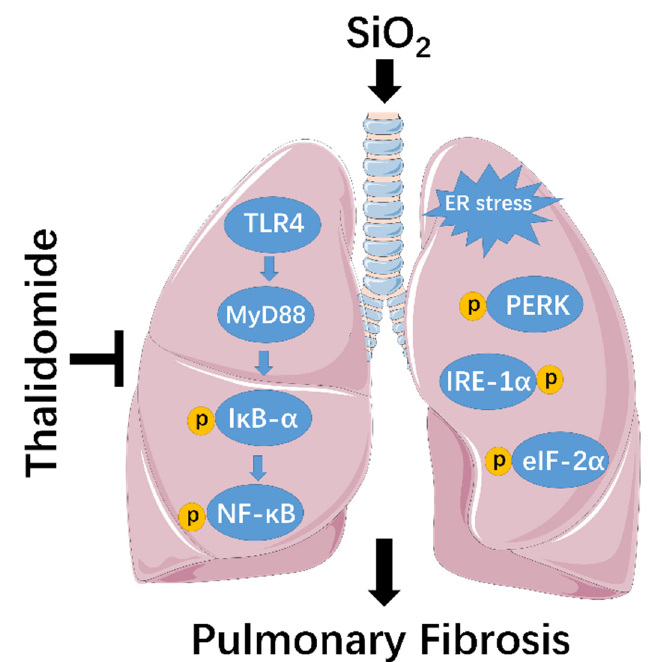
Figure 8. Thalidomide alleviates pulmonary fibrosis induced by silica in mice by inhibiting ER Stress and the TLR4-NF- κ B pathway.